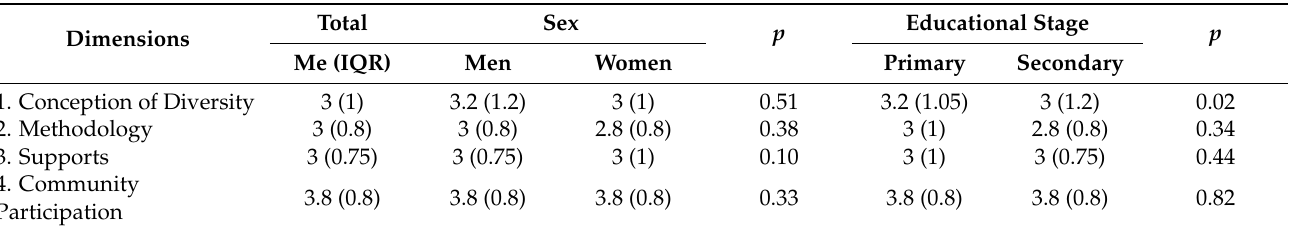
Table 4. CEFI-R descriptive analysis and differences of each Dimension, searching for differences between sex and educational stage.